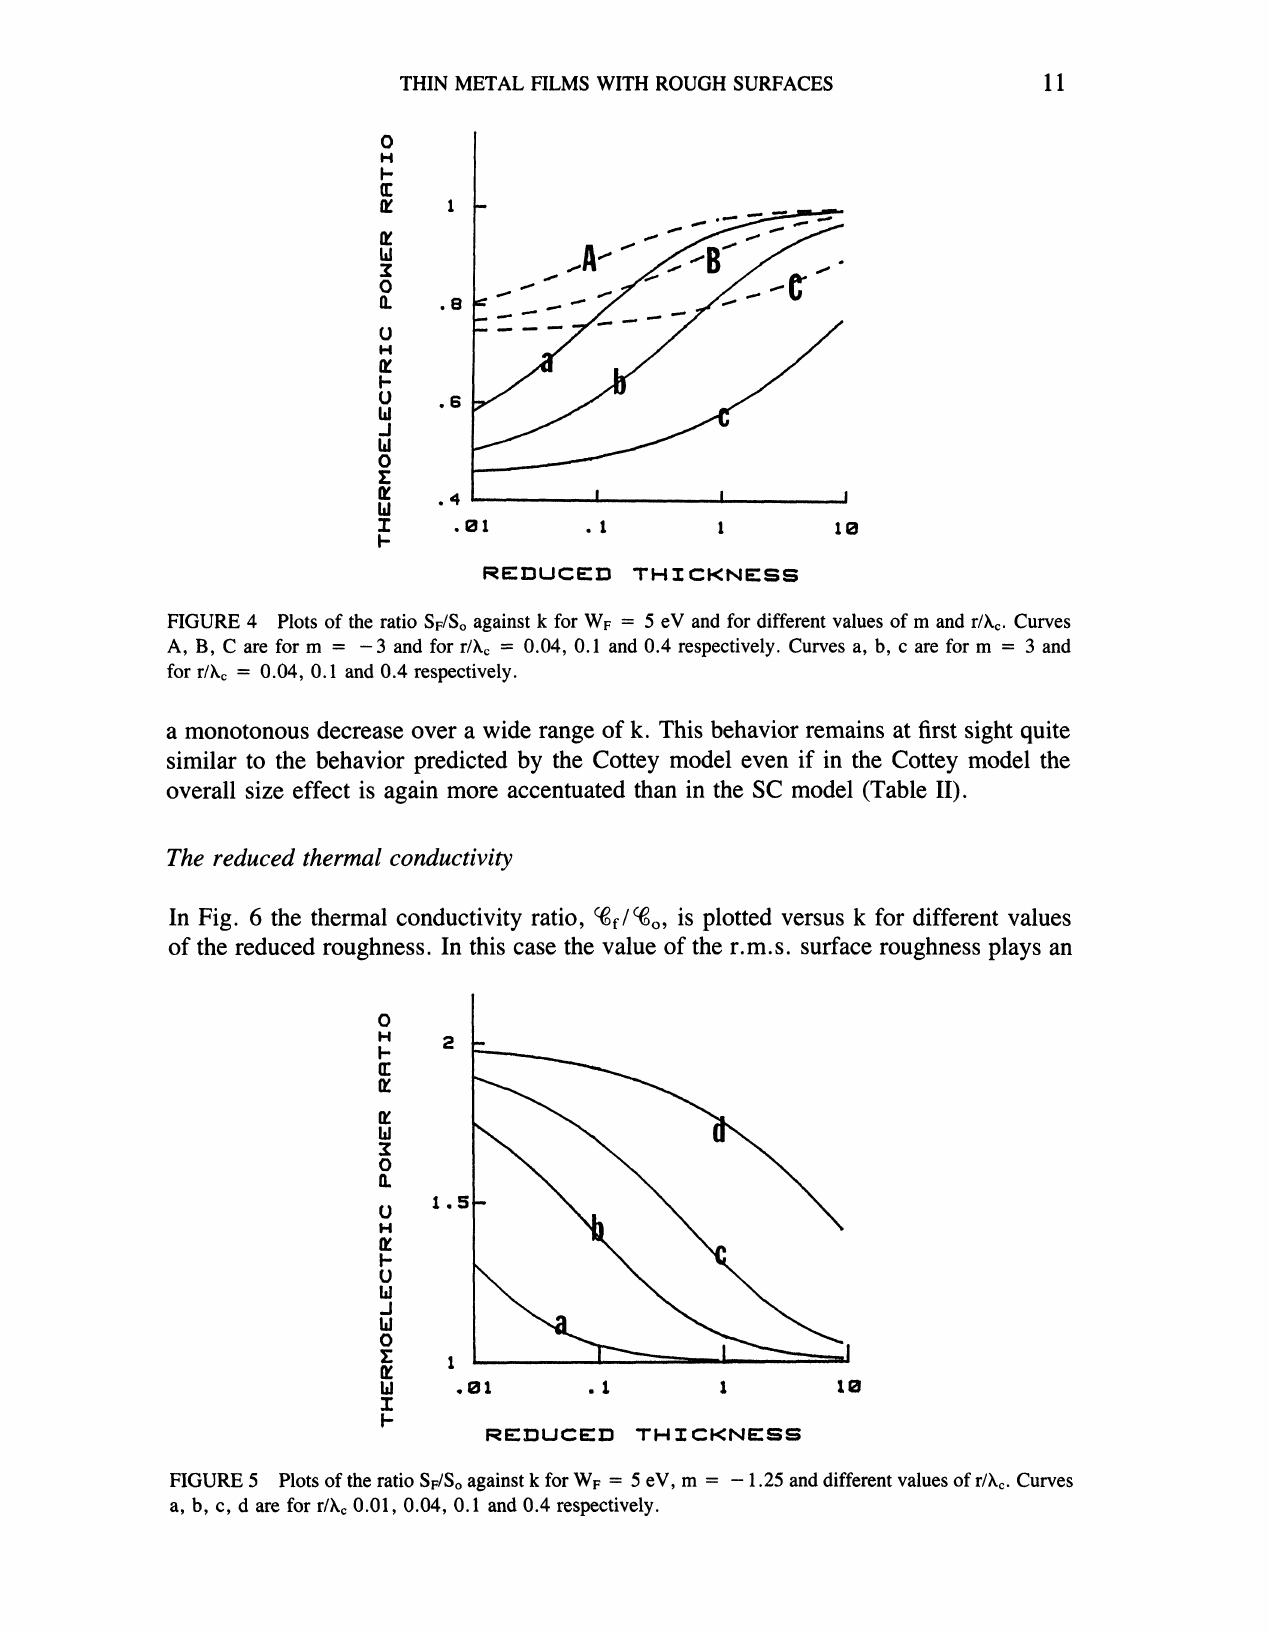
5 eV, m 1.25 and different values of r/h. Curves a, b, c, d are for r/hc 0.01, 0.04, 0.1 and 0.4